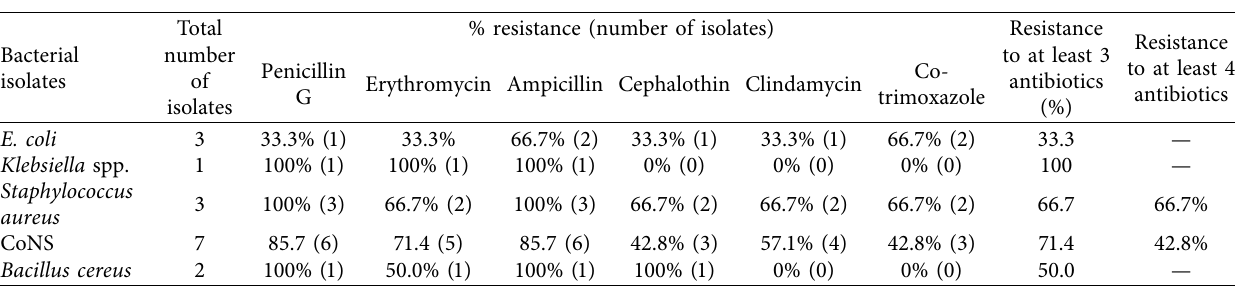
Figure 3: The impact on microbial contamination of the washroom environments by using hand air dryers. Table 1: Antibiotic resistance of bacterial